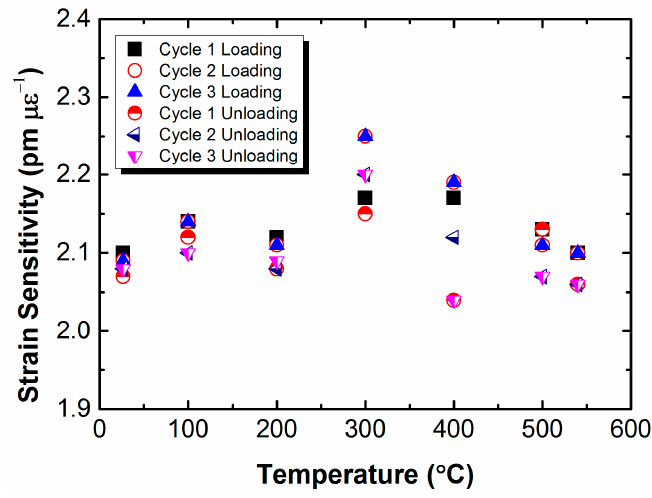
Figure 11. Strain sensitivity of the metal-packaged strain sensor based on the RFBG in H 2 -loaded PS1250/1500 fiber obtained from mechanical load-cycling tests as a function of temperature.